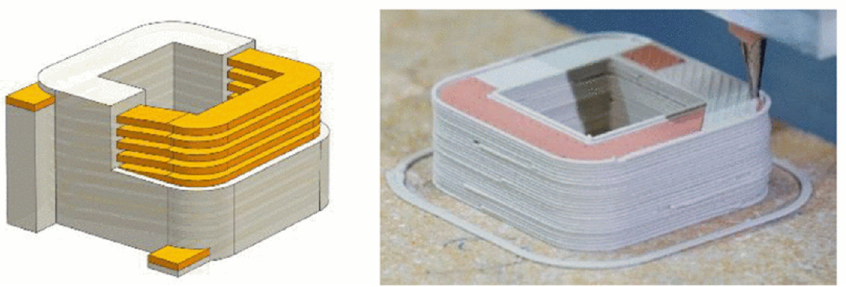
Figure 16. Additively manufactured windings with ceramic insulation for a switched reluctance motor. Reprinted with permission from Ref. [35]. Copyright 2018 Elsevier.